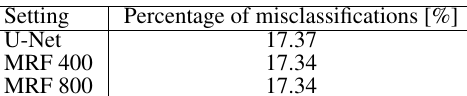
Figure 3. RGB image fragment around the park paths. The image appears very dark because of the 16-bit representation of Table 4. Detection rate of misclassifications with H 1 and H 2 color values. while 20 % of the pixels with highest uncertainty are